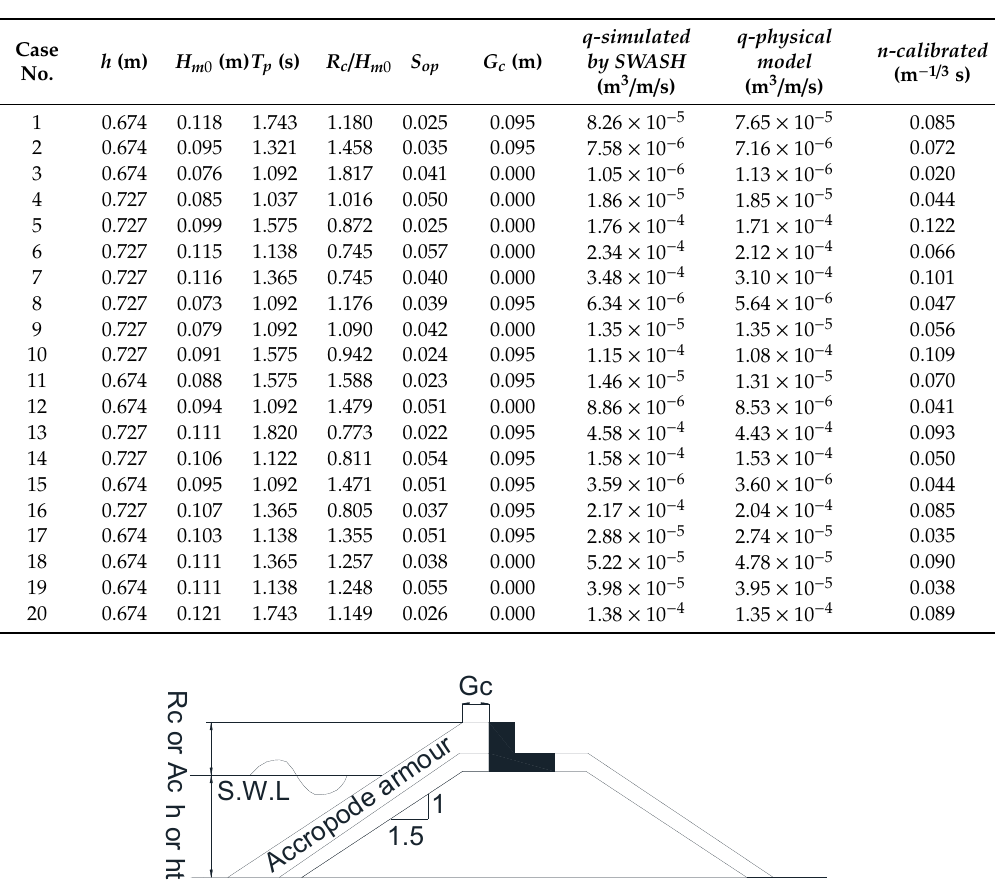
Table 1. The physical model parameters and the comparison of q between the numerical simulation and physical model of the CLASH database.